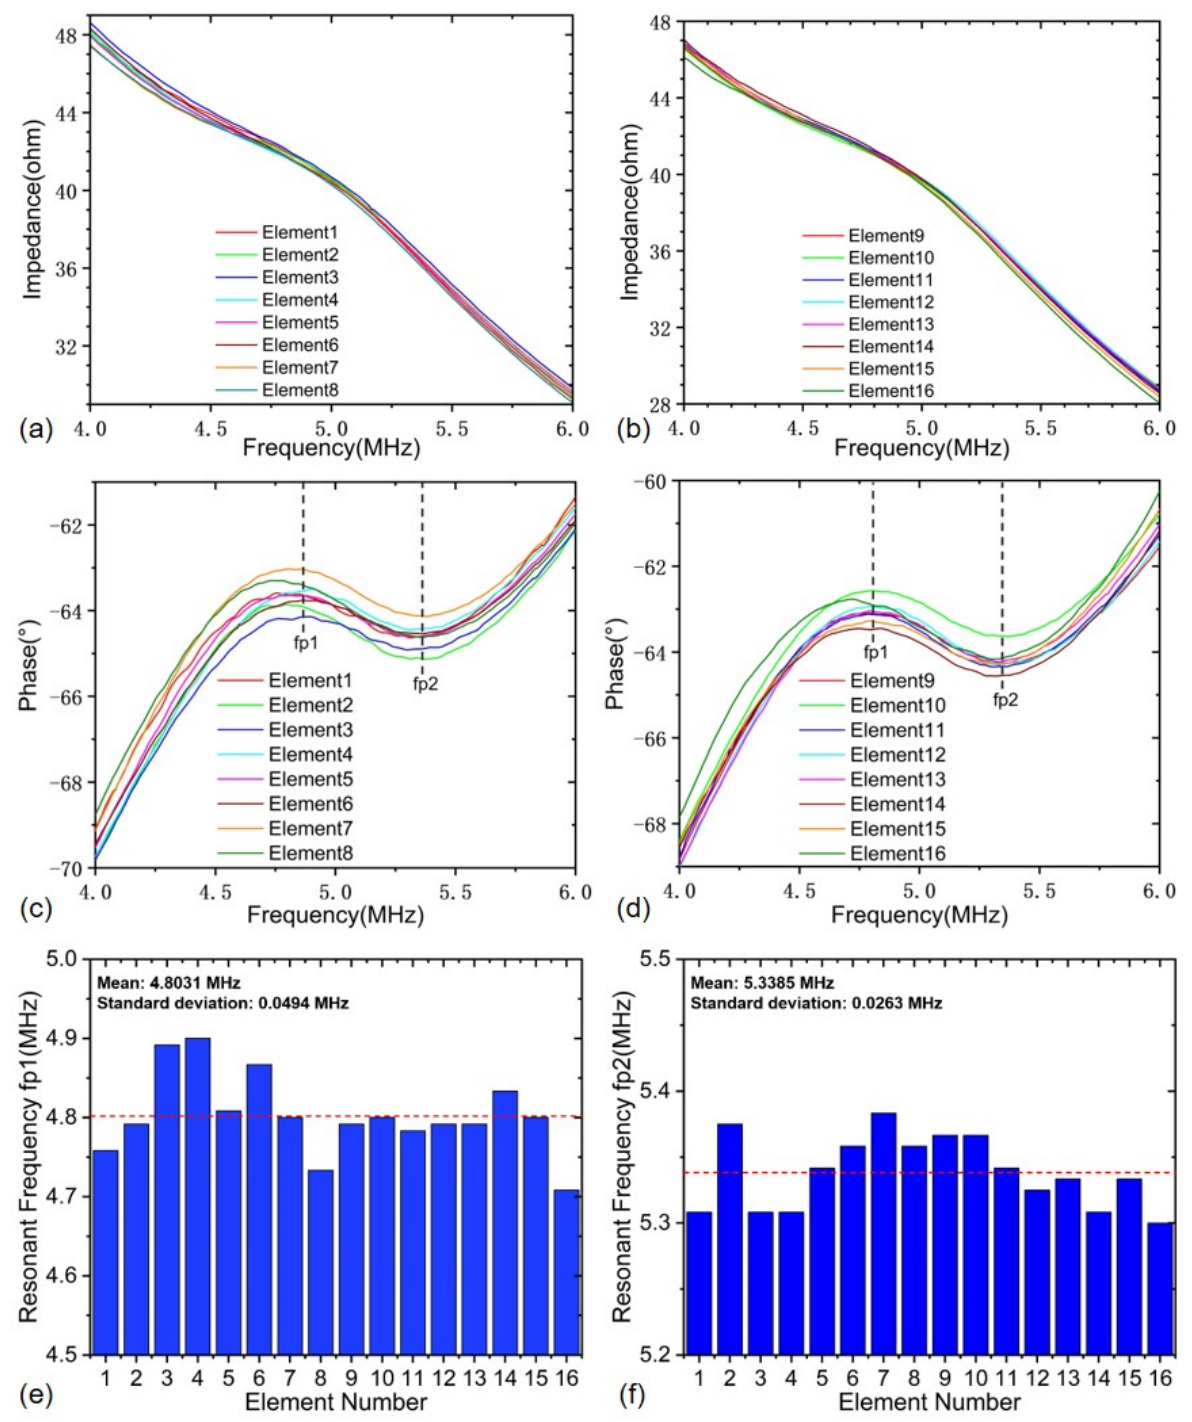
Figure 5. Impedance and phase spectrums of the developed PMUT linear array probe: ( a ) impedance curves for 1–8 elements, ( b ) impedance curves for 9–16 elements, ( c ) phase curves for 1–8 elements, ( d ) phase curves for 9–16 elements, ( e ) resonance frequency ( f p 1 ) of each element, ( f ) resonance frequency ( f p 2 ) of each